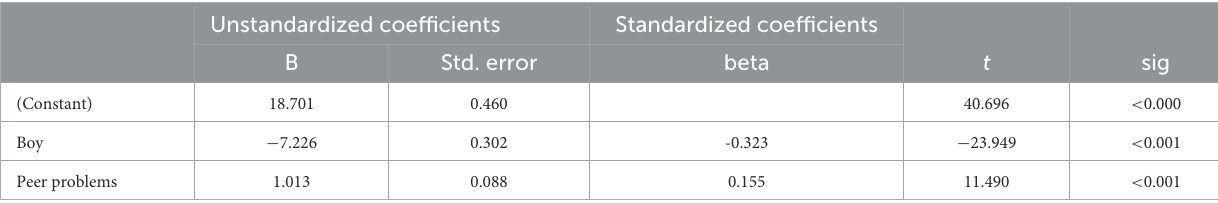
TABLE 3 Regression analysis in the HBSC sample of peer problems on gaming intensity, controlled for